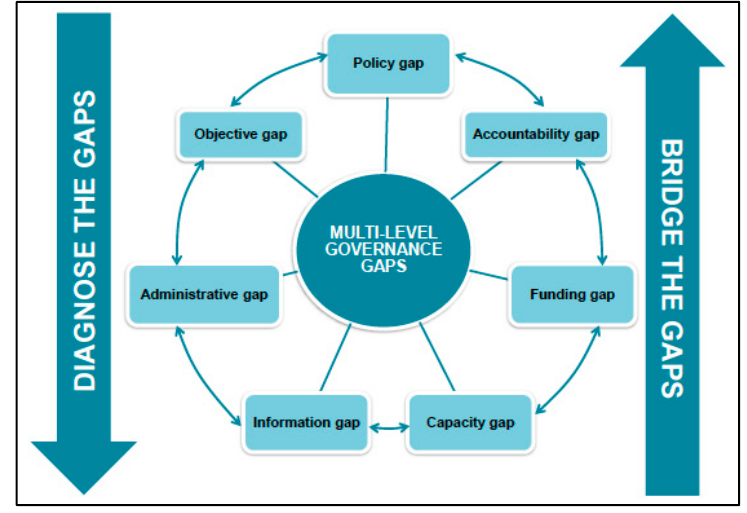
Figure 1. Multilevel Governance Gaps [3].